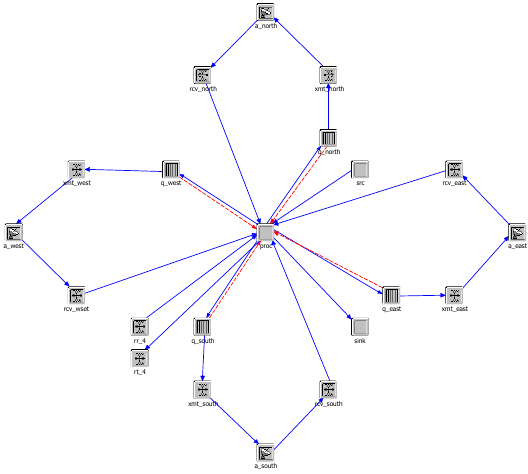
Figure 5. The model of satellite nodes in the simulation